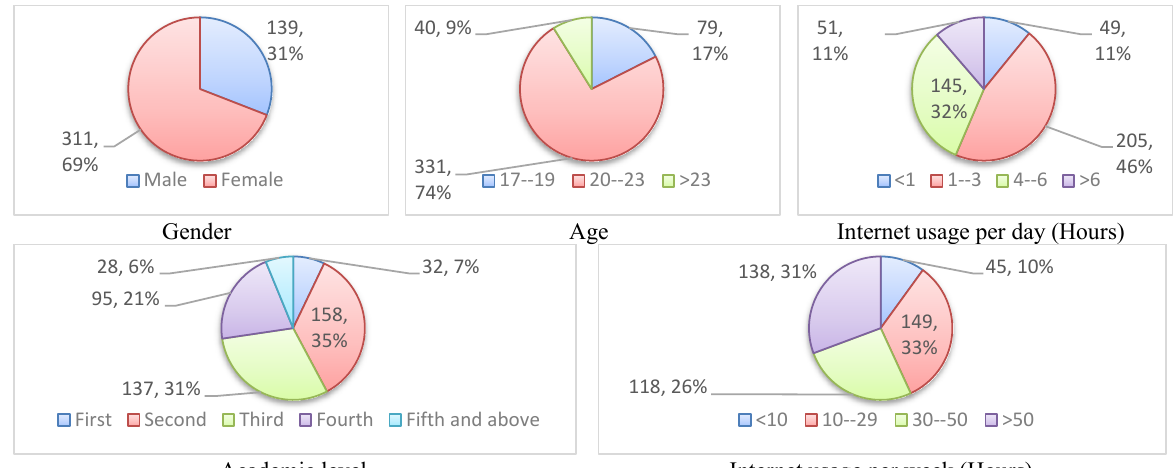
Fig. 2. Characteristics of the research sample (n =450)